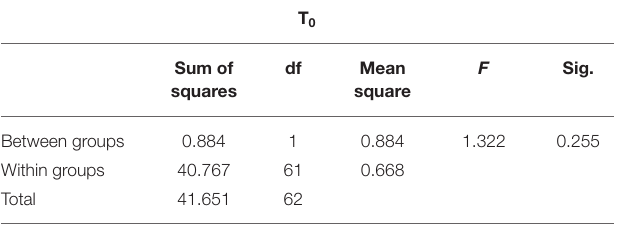
TABLE 2A | Group descriptive statistics at T 0 and T 1 .